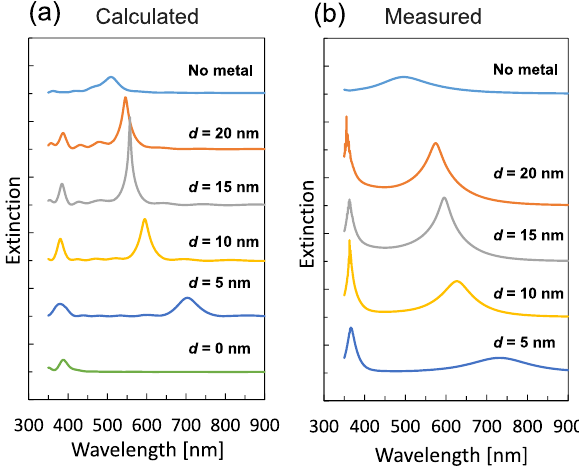
Figure 6: Dependency on the extinction spectra as a function of spacerthickness(from0 to 20nm)ofthe nanohemisphereonmirror (NHoM) structure obtained based on finite difference time domain (FDTD) simulations (a) and experimental measurements